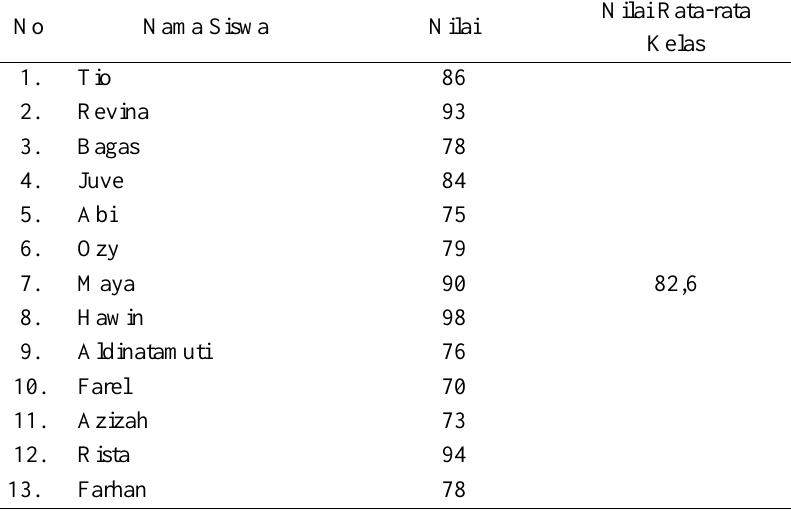
Tabel 3. Hasil Penilaian Post-Test pada Siklus